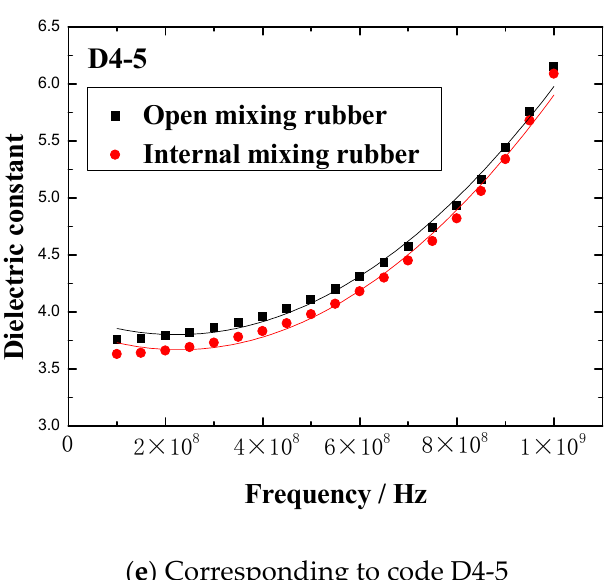
Figure 7. The dielectric constant vs. frequency plots of the rubber samples with different mixing process.